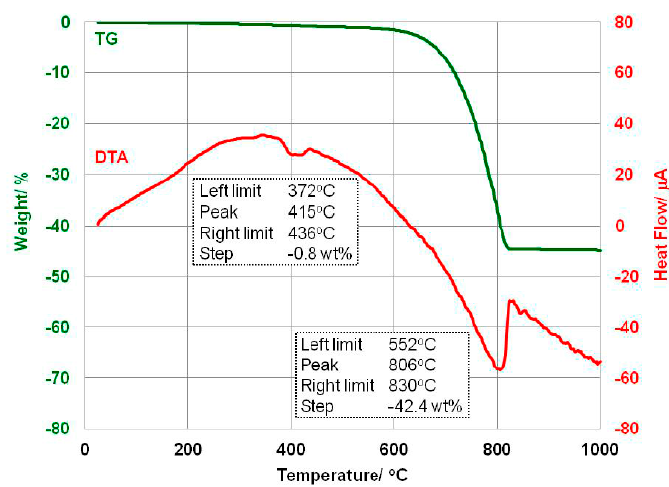
Figure 2. Simultaneous TG (green)-DTA (red) curves of the as-prepared calcium carbonate powder.